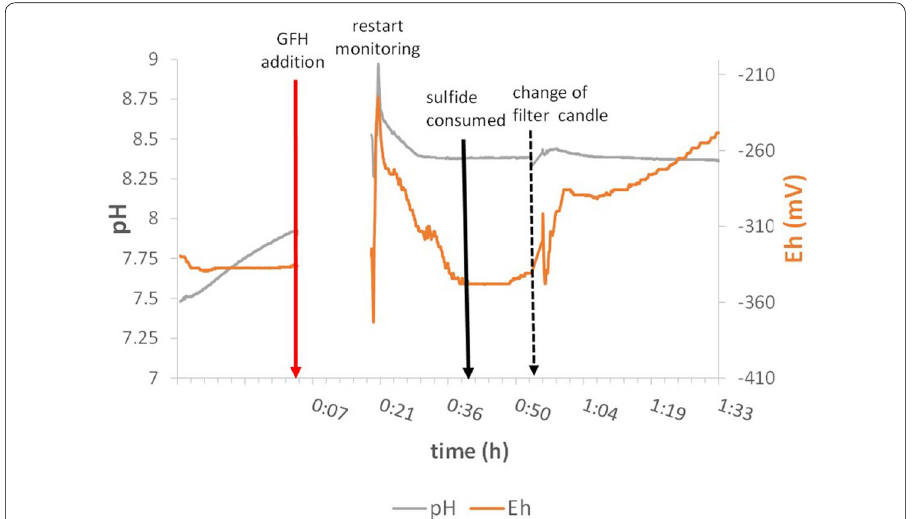
Fig. 5 pH and Eh monitoring by the fluid monitoring device FluMo during experiment D after the